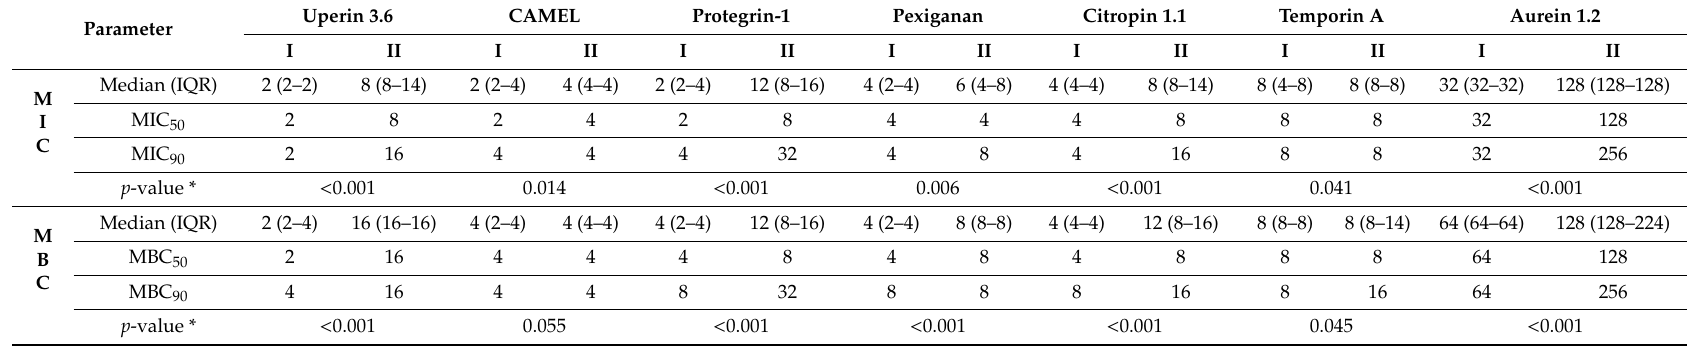
Table 2. Minimal inhibitory concentrations (MIC) and minimal bactericidal concentrations (MBC) of the tested antimicrobial peptides against the canine S. pseudintermedius (I) and S. aureus (II) strains.